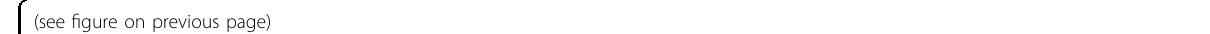
Fig. 2 Leave-one-out analysis and funnel plot of univariable bipolar-schizophrenia results. a Leave-one-out analysis to evaluate whether any single instrumental variable was driving the causal association of BIP-SCZ with self-reported COVID-19 disproportionately. As can be appreciated from the graph, no genetic variant altered the pooled beta coef fi cient, indicating the stability of our results. b Generalized funnel plot of univariable MR analysis of BIP-SCZ genetic liability effects on self-reported COVID-19 with fi rst-order IVW and MR-Egger regression slopes to look for asymmetry as a sign of pleiotropy. This kind of graph plots the ratio estimate for each variant on the horizontal axis against its square-root precision (or weight) on the vertical axis. As can be appreciated from the plot, no evidence for asymmetry was detected, indicating the absence of directional pleiotropy and the instrument strength independent of direct effect (InSIDE) assumption to be satis fi